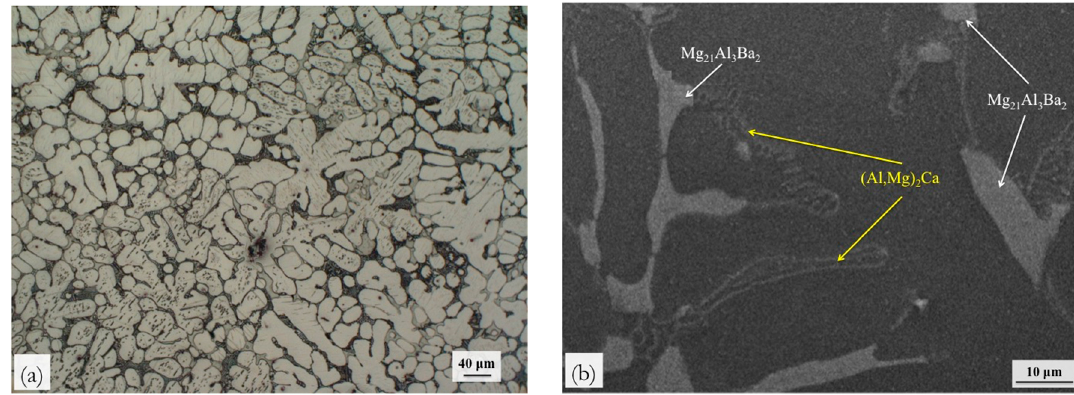
Figure 1. Initial microstructure of the ABaX633 alloy in the as-cast condition: ( a ) Optical micrograph; ( b ) SEM image.